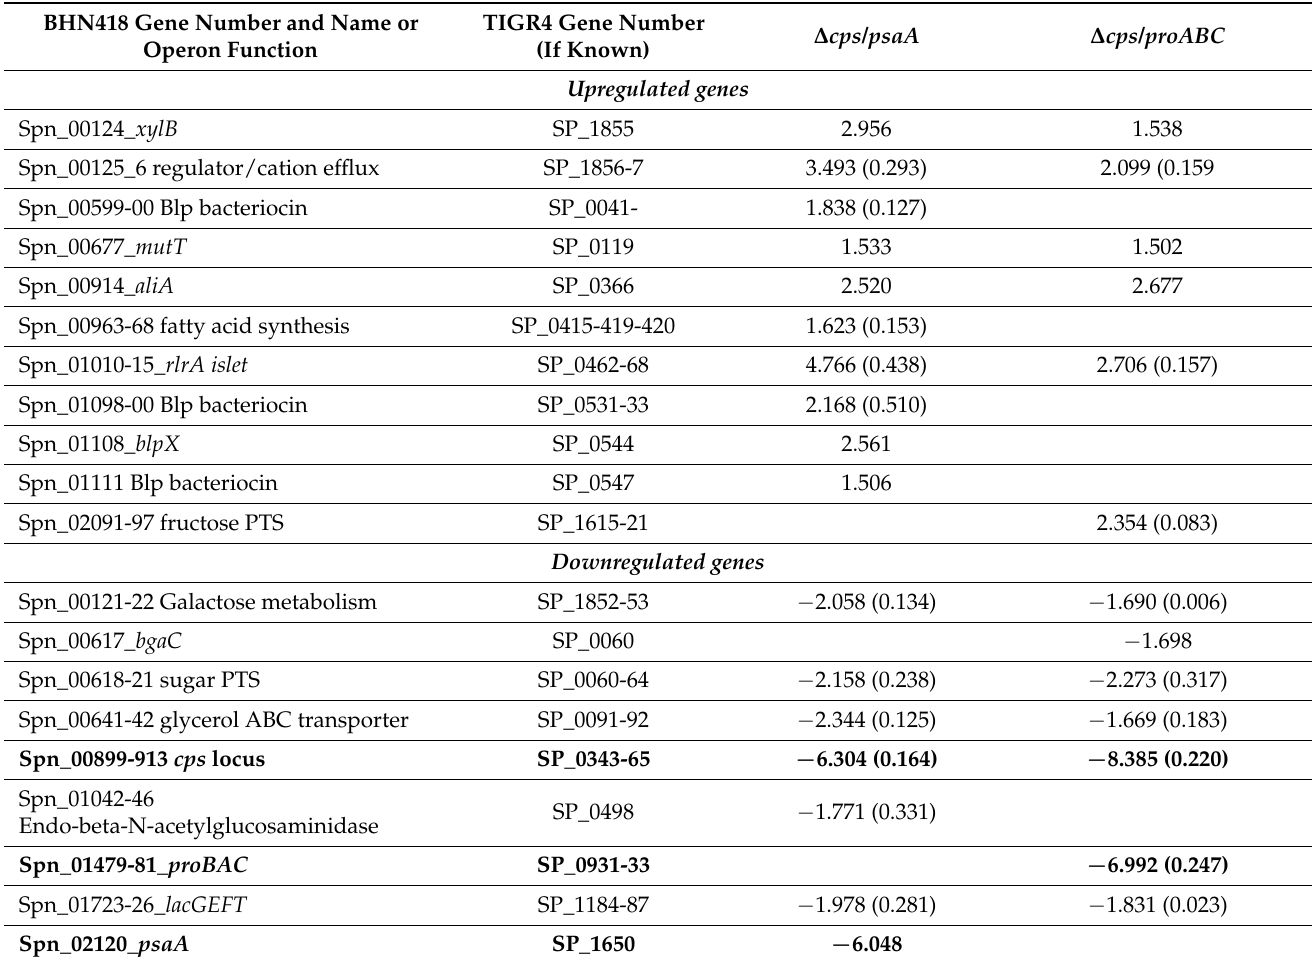
Table 1. RNA-seq data. Selected S. pneumoniae genes and operons showing statistically significant differential expression between the double mutant strains and the wild type 6B strain when cultured to mid-log growth phase in THY broth. Gene numbers for both BHN418 and the TIGR4 strain are given, along with gene names where these have been described. Data are presented as log 2 fold change (either for a single gene or mean and SD values for all genes in an operon) and include only genes with >1.5 log 2 differences. Genes or operons marked in bold are deleted in the mutant strains ( cps